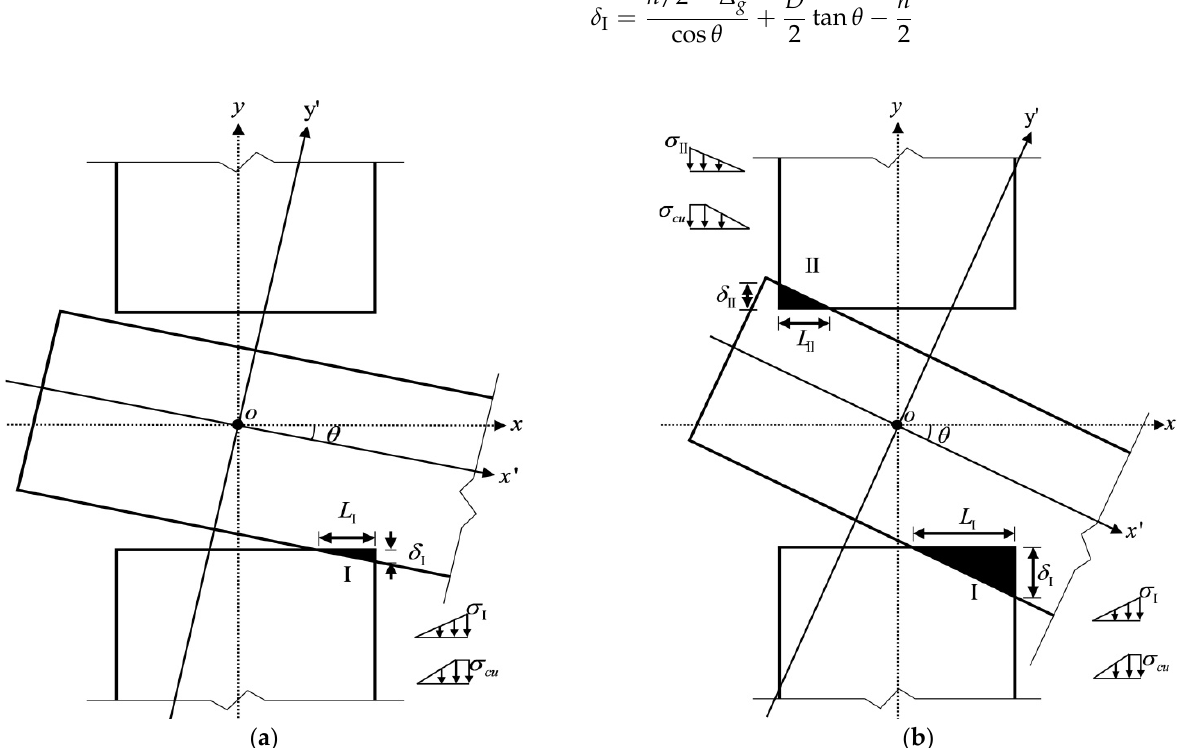
Figure 8. Stress state: ( a ) Compression state I and ( b ) Compression state Ⅱ. (b) Physical conditions in the elastic state